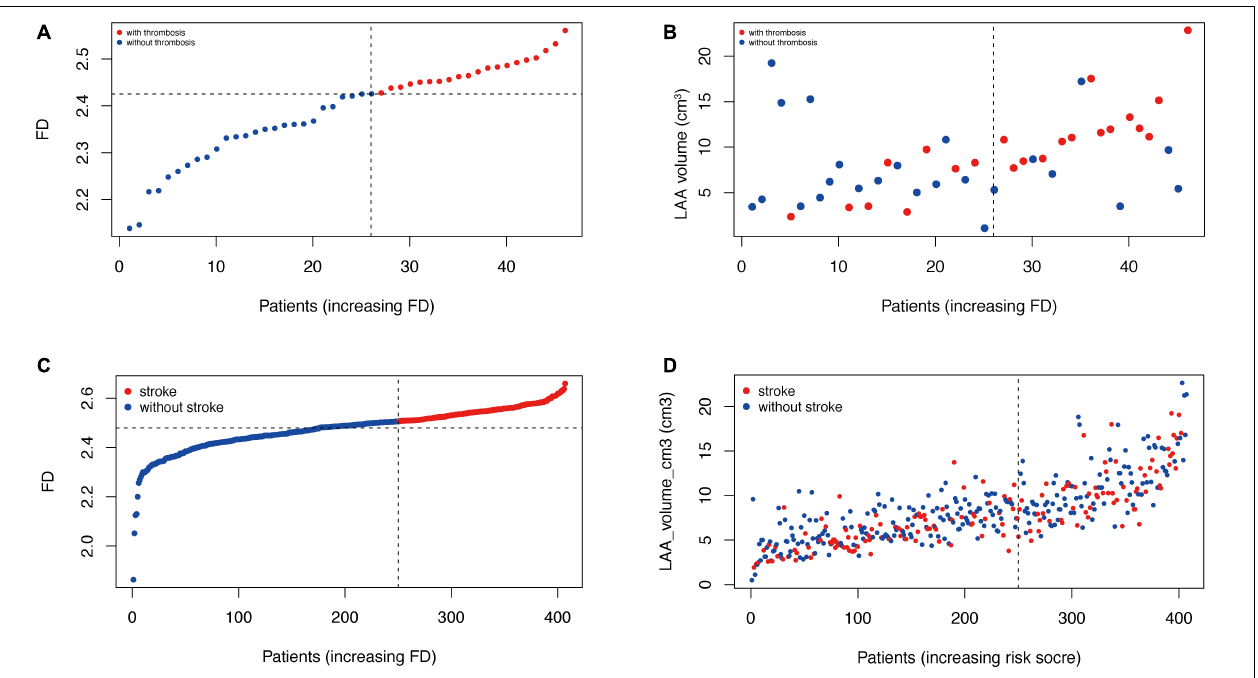
FIGURE 5 | Risk plot of training and validation cohort. (A,C) LAA box-counting dimension of each patient is plotted and presents the cutoff value that defines high- and low-risk patients in the training and validation cohorts, respectively. (B,D) Each patient’s LAA volume is plotted with its box-counting dimension, suggesting the positive correlation between LAA volume and morphological complexity.